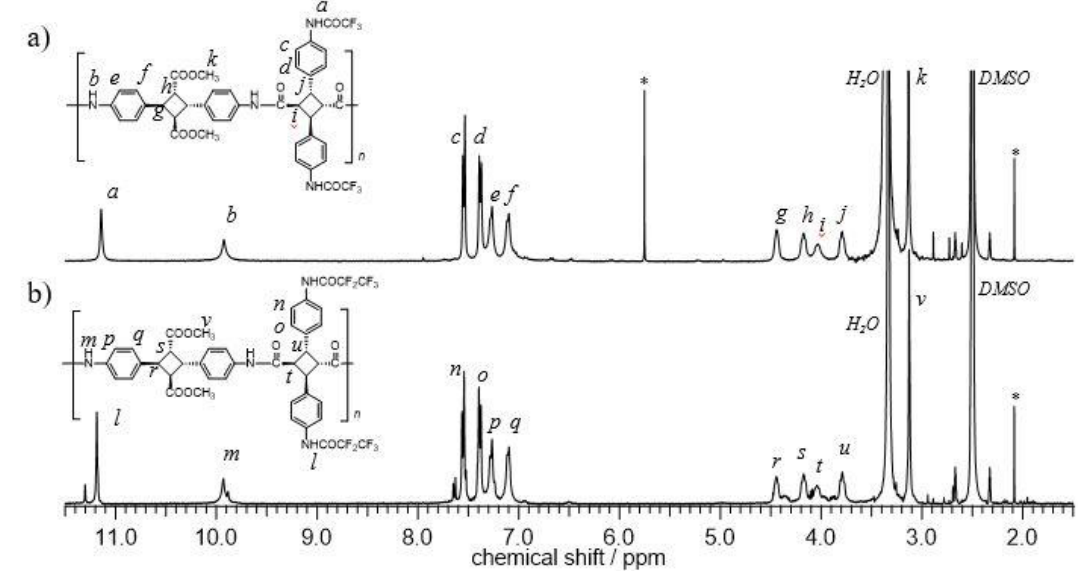
Figure 1. 1 H NMR spectra of the PA-F1 ( a ) and PA-F2 ( b ) (Solvent, DMSO- d 6 ; [*] indicated residual solvent).